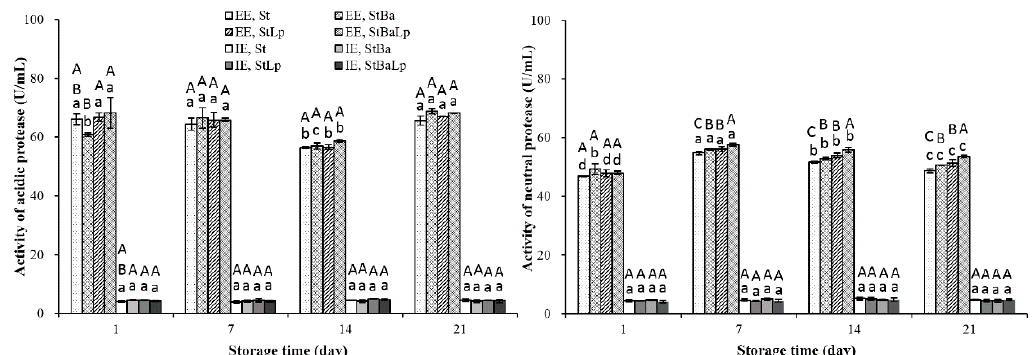
Figure 1. Changes in protease activity (U/mL) in fermented milk from different starter cultures during 21-day storage at 4 °C. Note: Data are means ± standard deviation ( n = 3). Bars marked with different lower-case letters indicate significant differences among days of storage for the same batch of fermented milks ( p < 0.05); bars marked with different upper-case letters indicate significant difference among starter cultures within the same period ( p < 0.05).